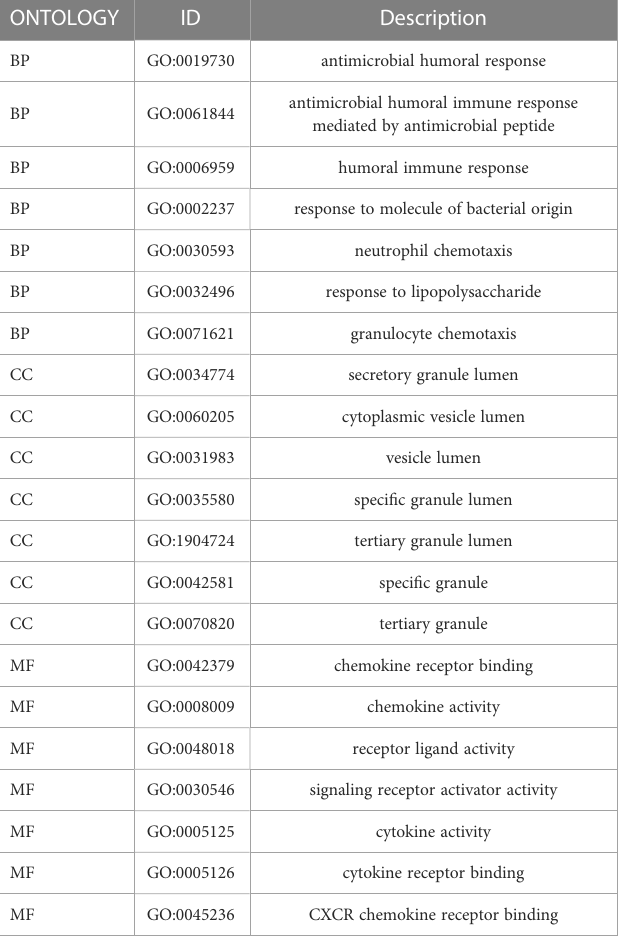
TABLE 1 GO enrichment results for 65 DEGs.